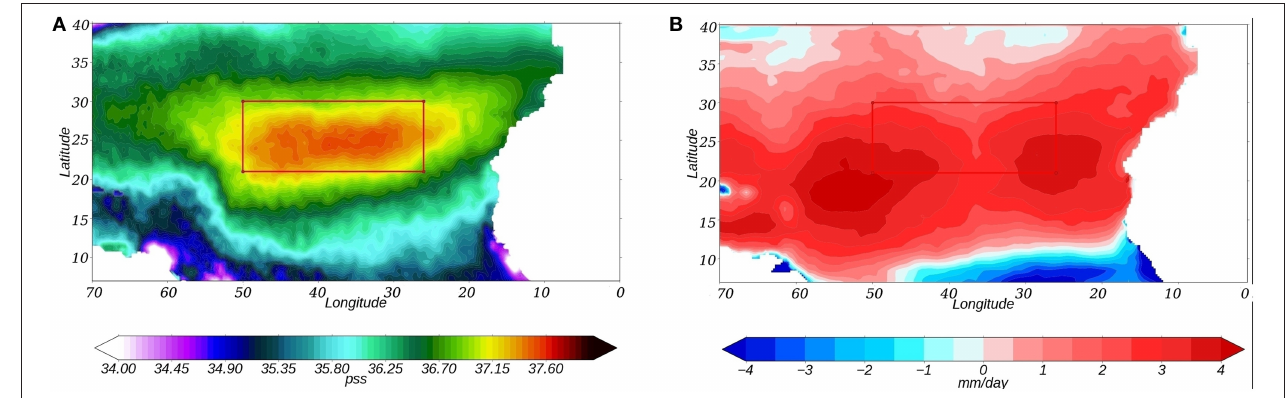
FIGURE 8 | Annual salinity (A) and E-P (B) mean with the selected region for SSS budget estimation (red box) over the August 2012—August 2013.